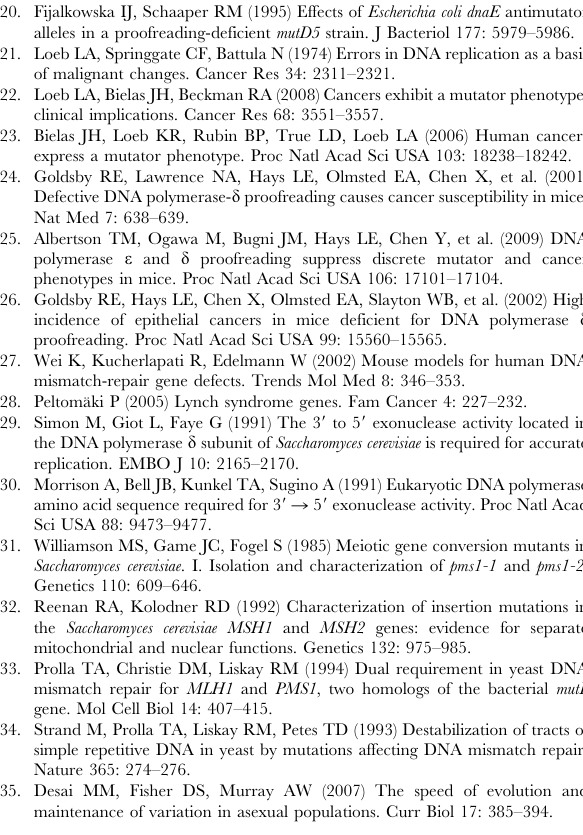
Figure S5 eex amino-acid substitutions near the template nucleotide in Pol d . Schematic of the a -carbon backbone of Pol d with residues of interest depicted as space-filling spheres.